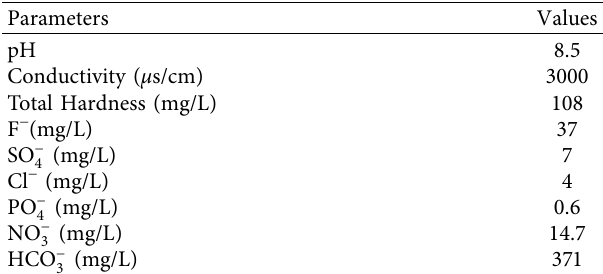
Table 1: The physicochemical properties of the Dugda-Bora groundwater with maximum fluoride